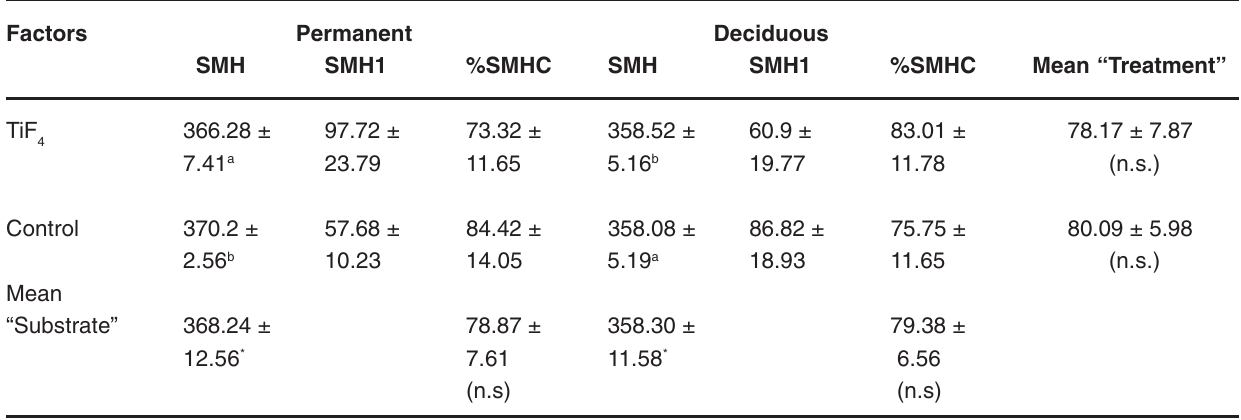
Values followed by “n.s.” means no significant differences for the both factors (two-way ANOVA, p>0.05). Values followed by different superscripts letters indicate statistically significant differences between the groups (Tukey’s test, n=10, p<0.05). * indicates a significant difference between the initial surface microhardness of permanent enamel and deciduous enamel (Student t’ test, n=20,